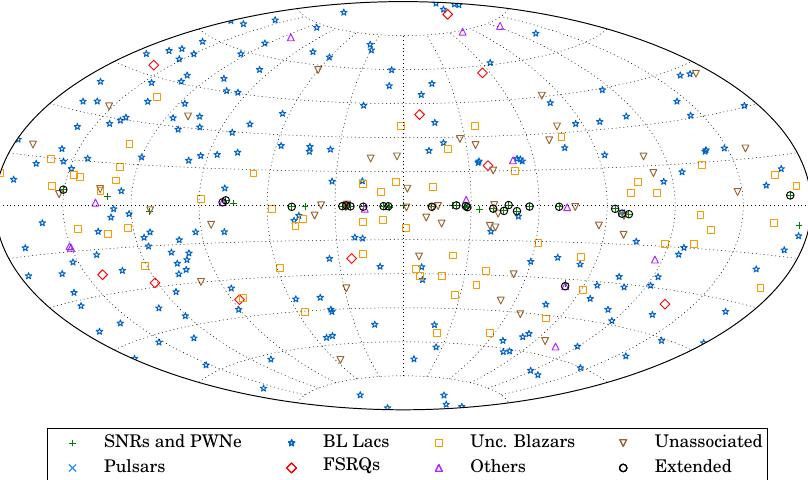
Figure 4. Sky map, in Galactic coordinates and Hammer-Aitoff projection, showing the sources in the 2FHL catalog classified by their most likely association [24]. ( c (cid:13) American Astronomical Society, AAS. Reproduced with permission.)